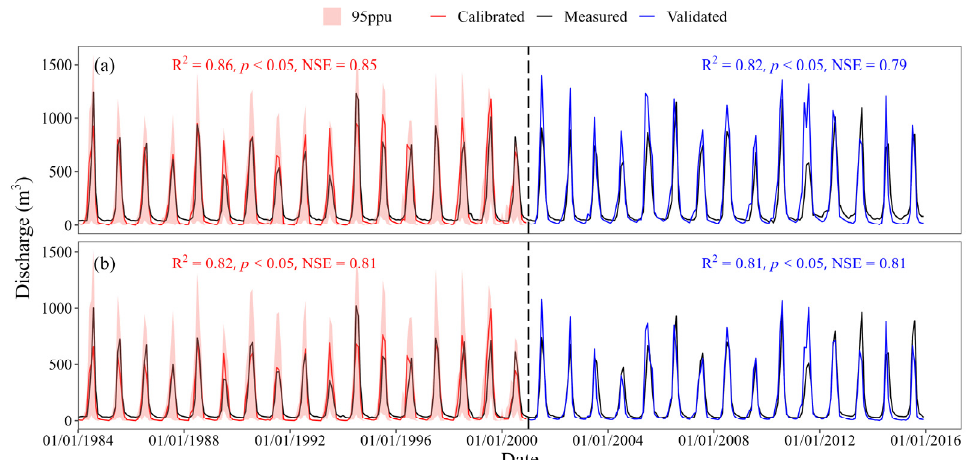
Figure 7. Comparison of simulated and measured monthly discharge rate after calibration and val- idation (1984–2015) in which calibration period ranged from 1984 to 2000 (light grey background), validated period ranged from 2001–2015; ( a ) Kaqun station, ( b ) Kuluklangan station.